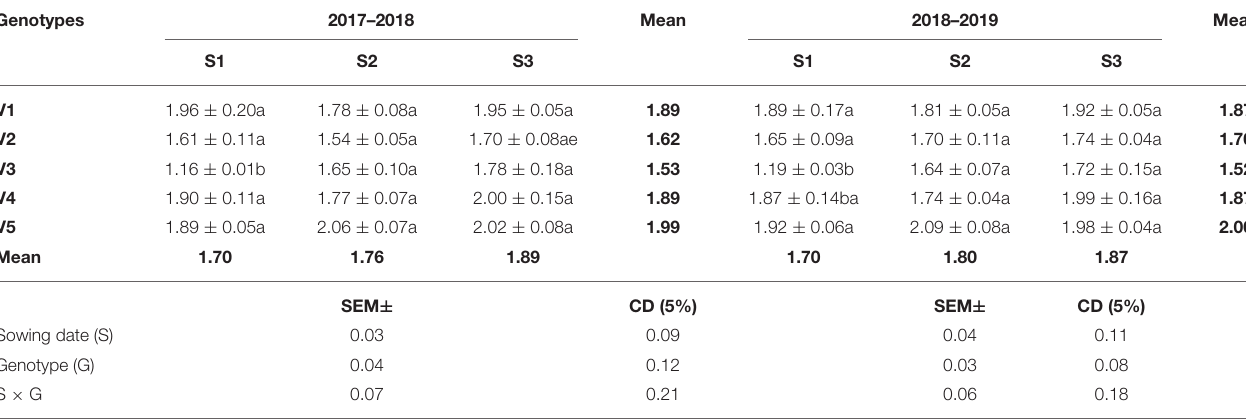
TABLE 4 | The POX activity (EU mg − 1 protein min − 1 ) at mid-flowering stage in top leaf of mustard varieties sown at three different dates during rabi 2017–2018 and 2018–2019.